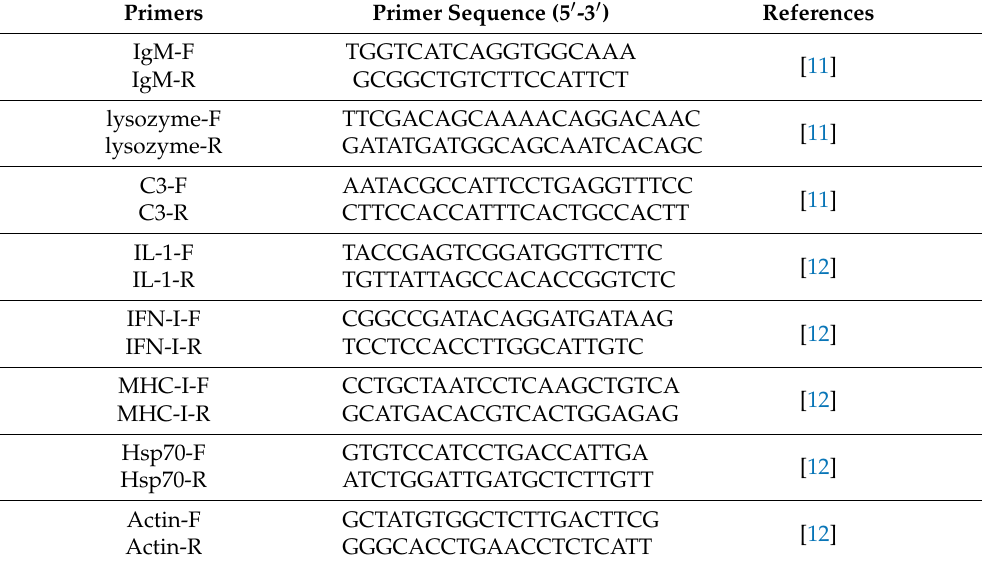
Table 3. The primers used in this study.